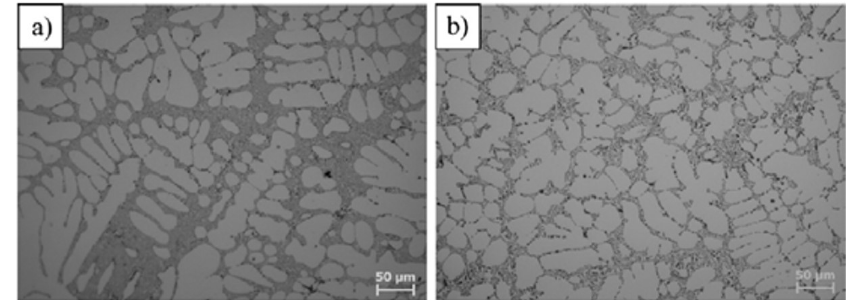
Figure 1. Details of the distribution of the secondary eutectic Si phase and b-Fe precipitates in Al-Si alloys: (a) without inoculation (reference) and (b) with inoculation (NbB